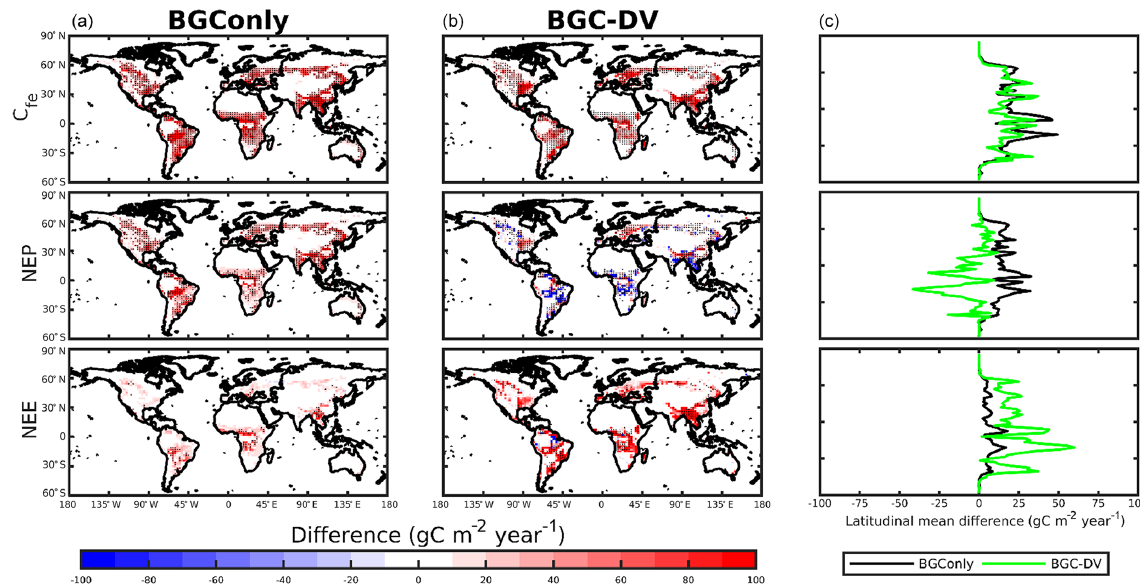
Figure 6. Differences in carbon emissions ( C fe ), net ecosystem production (NEP), and net ecosystem exchange (NEE) caused by fires in BGConly (BGConly-F minus BGConly-NF; a ) and BGC-DV (BGC-DV-F minus BGC-DV-NF; b ). Hashed areas indicate that the difference passed the Student’s t test at the 0.05 significance level. Latitudinal mean differences are plotted in (c) . Table 3. Annual means of carbon budget for gross primary production (GPP), NPP, R a , R h , NEP, NEE, and C fe and their differences between one with fire and one without fire (i.e., BGConly-F minus BGConly-NF and BGC-DV-F minus BGC-DV-NF) in PgCyr − 1 . Asterisk (*) indicates that the difference passed the Student’s t test at the α = 0 . 05 significance level.